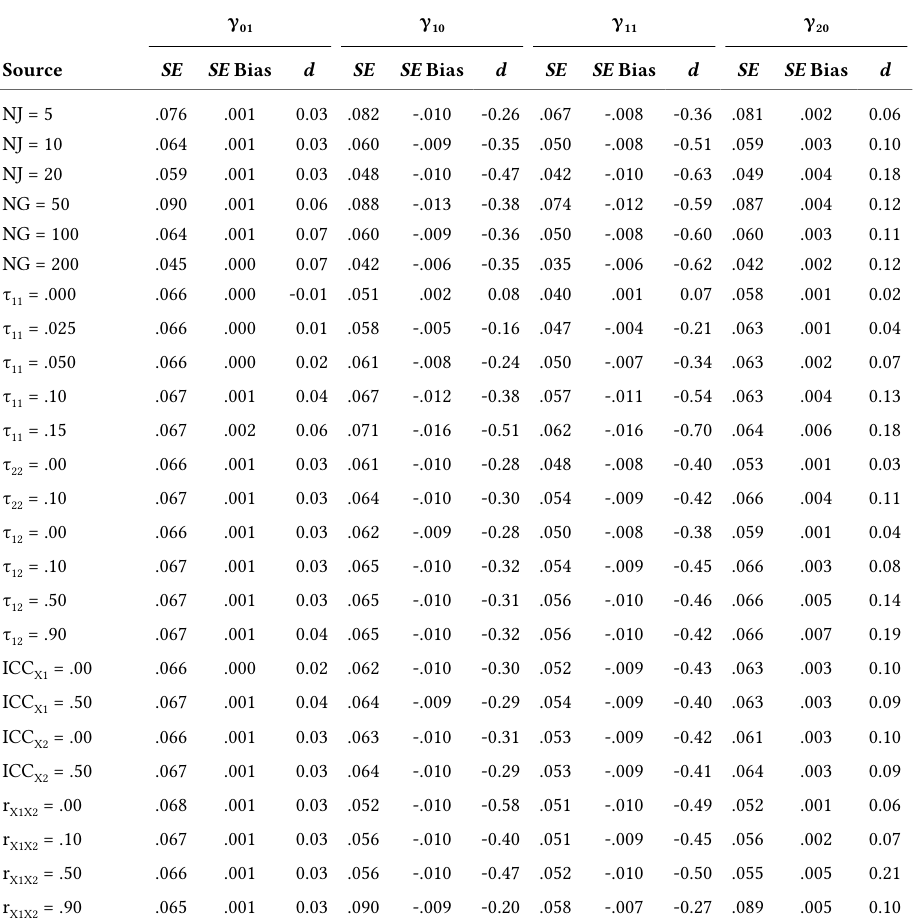
Bias Statistics for the Standard Error Differences in the Parameter Estimates Between a Model With a Fixed Slope and a Model With a Slope Allowed to